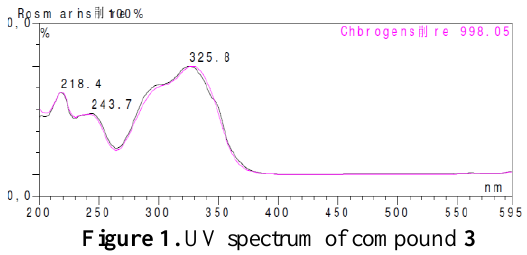
Figure 1. UV spectrum of compound